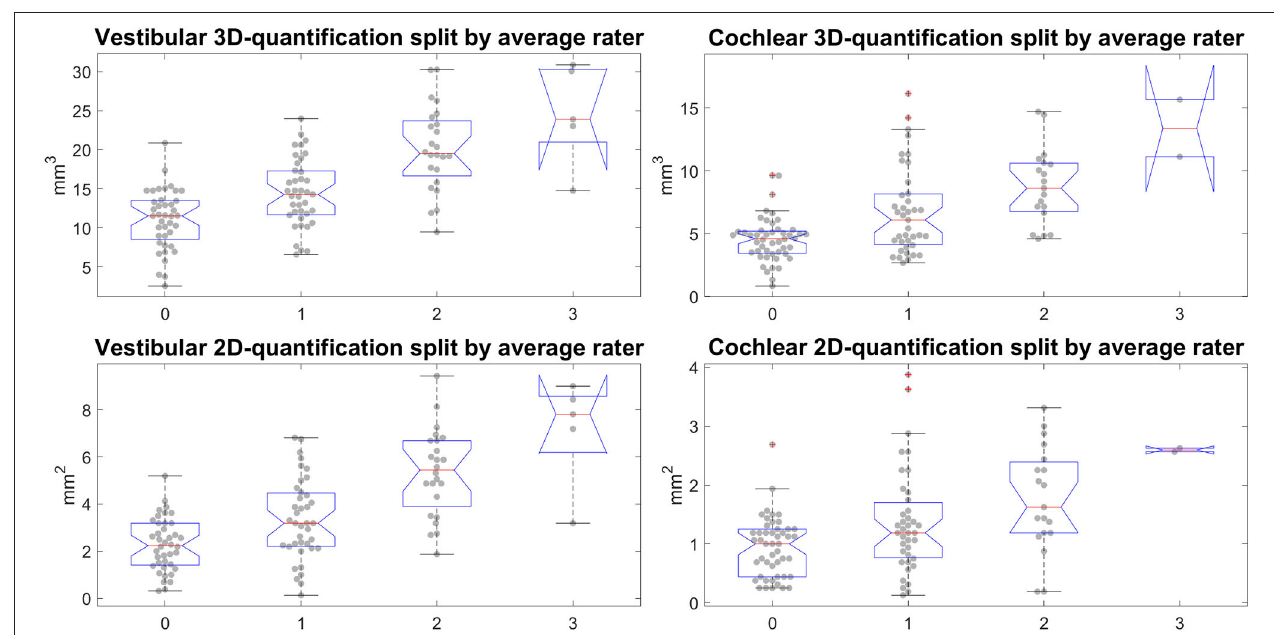
FIGURE 8 | Semi-quantitative (SQ) grade-specific 2D- and 3D-quantification values. These four plots show the quantitative endolymphatic hydrops (ELH) measures (3D-quantification in the top row and 2D-quantification in the bottom row) split up along the semi-quantitative visual grading steps (from grade 0 to grade 3 in steps of 1). This means each boxplot with data points overlaid shows the distribution of quantitative measures that correspond to the respective grading. The grading here is of the average over the three raters, rounded to the nearest integer to preserve gradings going from 0 to 3 in steps of 1. The top row shows the distributions for the 3D-quantification of ELH for vestibular and cochlear parts of the inner ear, left and right, respectively, while the bottom row shows the distributions for the 2D-quantification of ELH for vestibular and cochlear parts of the inner ear.